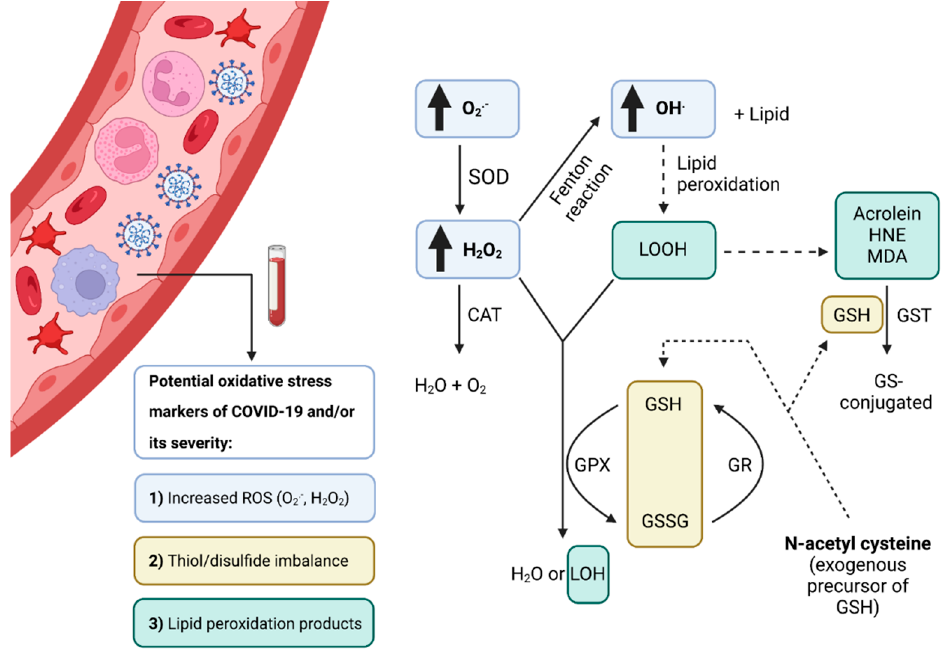
Figure 4. Oxidative stress biomarkers in COVID-19 development and severity. During SARS-CoV-2 infection, ROS levels are increased, and an imbalance between thiol and disulfide leads to lipid peroxidation. More specifically, O 2 . − is converted to H 2 O 2 via SOD, which is further converted into H 2 O and O 2 through CAT. In the Fenton reaction, levels of OH . are increased, which then reacts with lipids to initiate lipid peroxidation. Different lipid peroxidation products are derived from the process, ending with acrolein, HNE, and MDA. LOOH and H 2 O 2 are reduced to lipid alcohols and water, respectively, by GPX. In this enzymatic reaction, reduced GSH is converted to glutathione disulfide, which is then regenerated with GR. Acrolein, HNE, and MDA are conjugated with glutathione via the GST enzymatic reaction. Since a lot of glutathione is used in the process, N-acetyl